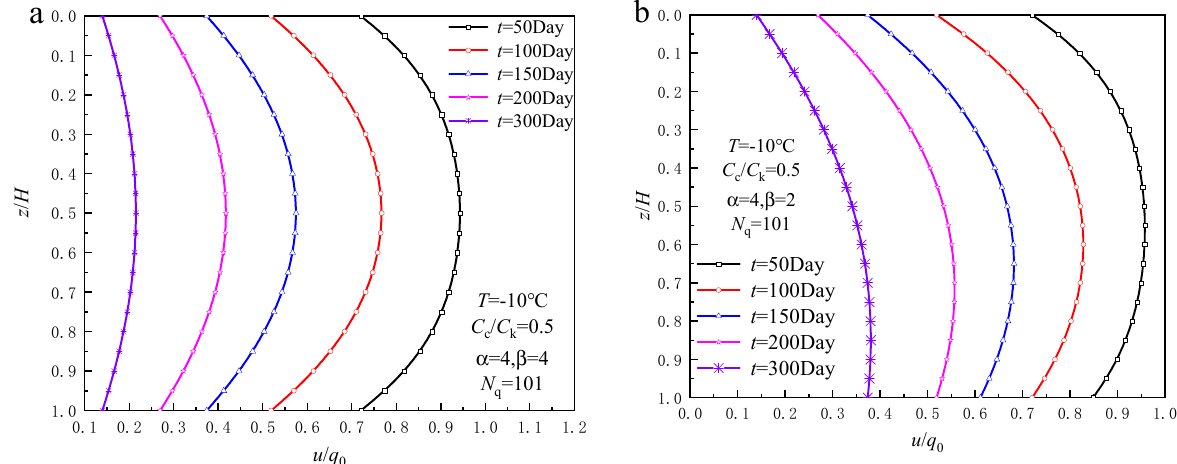
Figure 6. Influence of the time factor: ( a ) the distribution of excess pore water pressure when α = β , and ( b ) the distribution of excess pore water pressure when α (cid:54) = β .